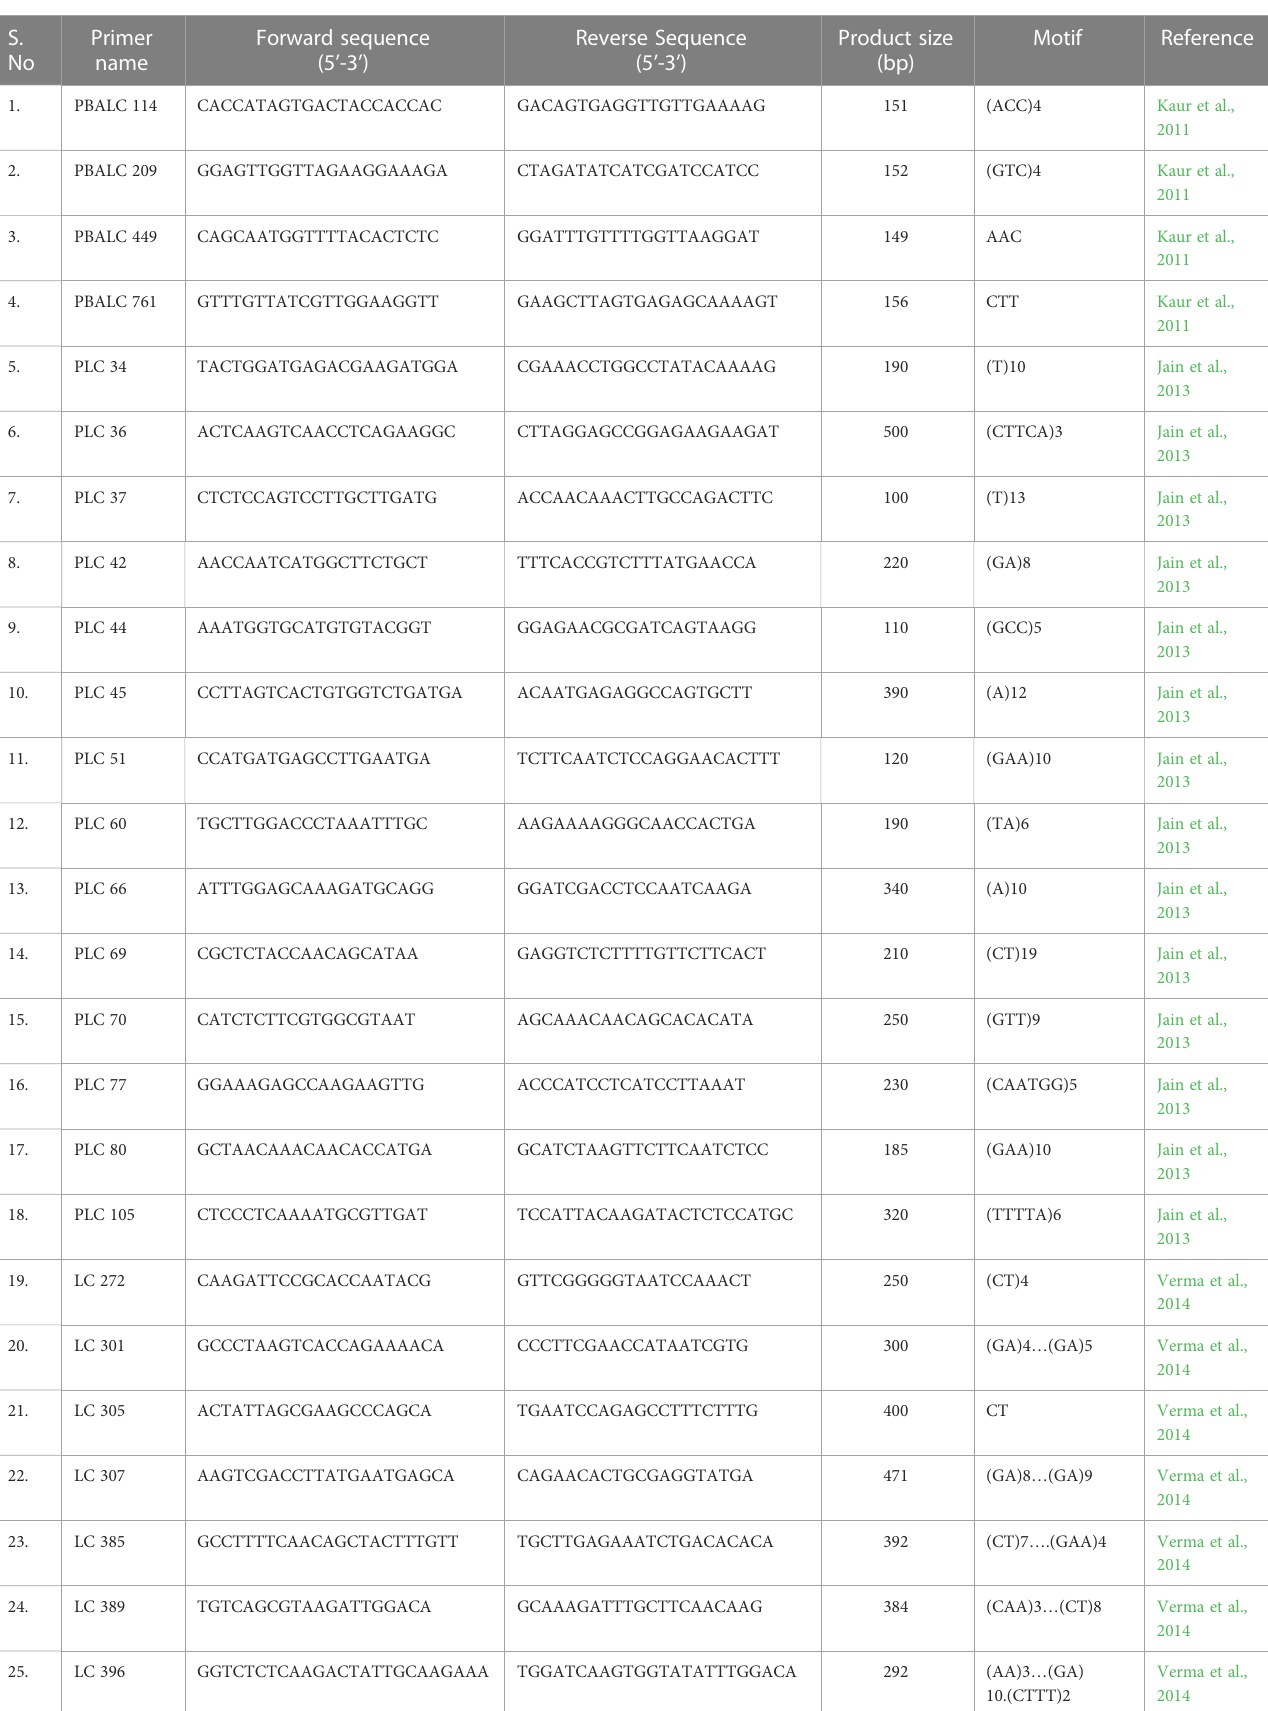
TABLE 1 Details of the SSRs found polymorphic between the parents L4602 and